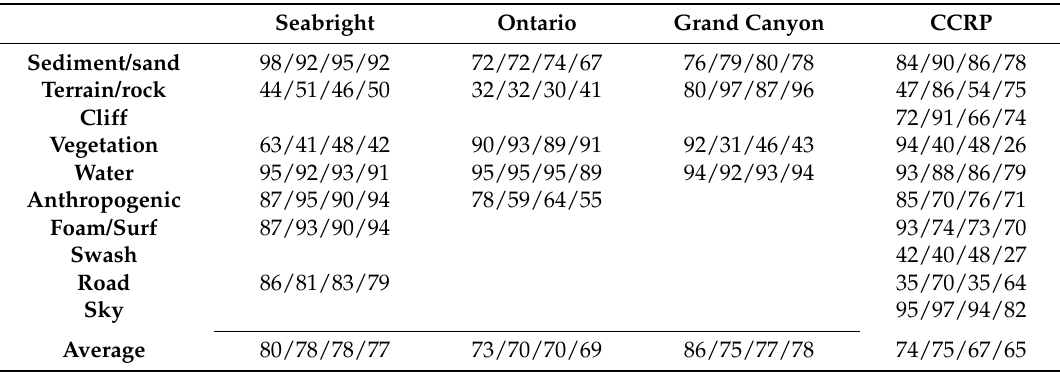
Table 3. Mean P/R/F/A (all %) per class for pixelwise classifications using each of the non-satellite datasets ( T = 96), using the test set of label